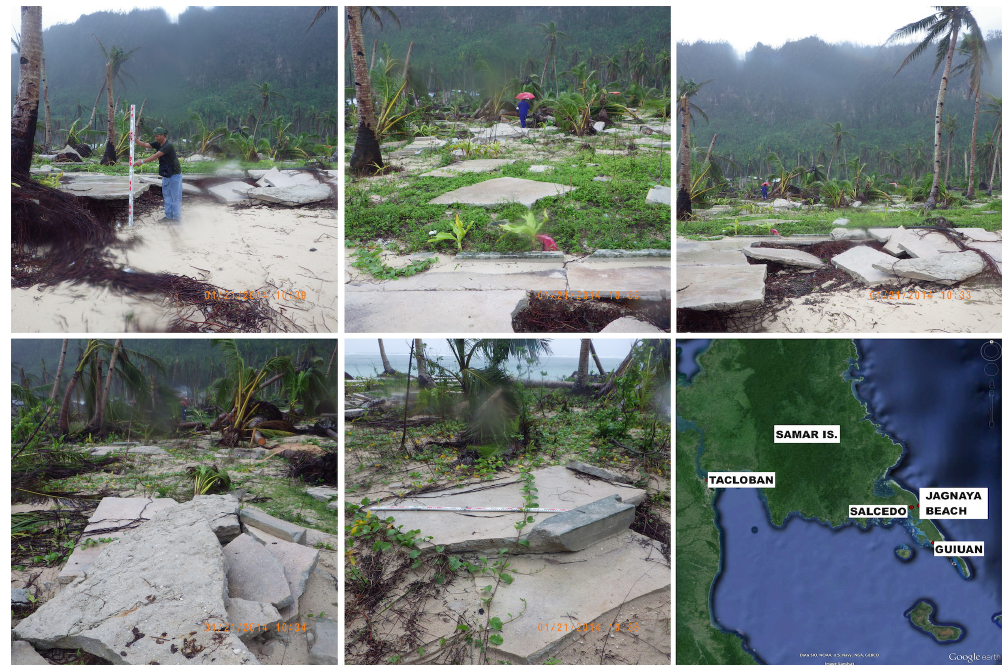
Figure 13. Guiuan village, one of the areas most affected by storm surge and superimposed storm waves. Sand erosion, vegetation damage and destroyed concrete structures were